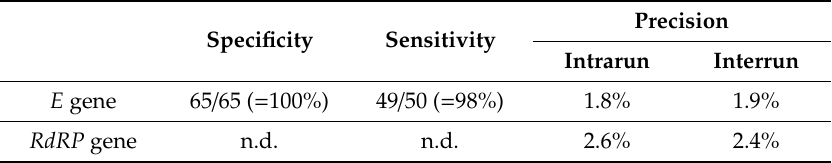
Table 1. Basic validation characteristics of the assay. n.d., not